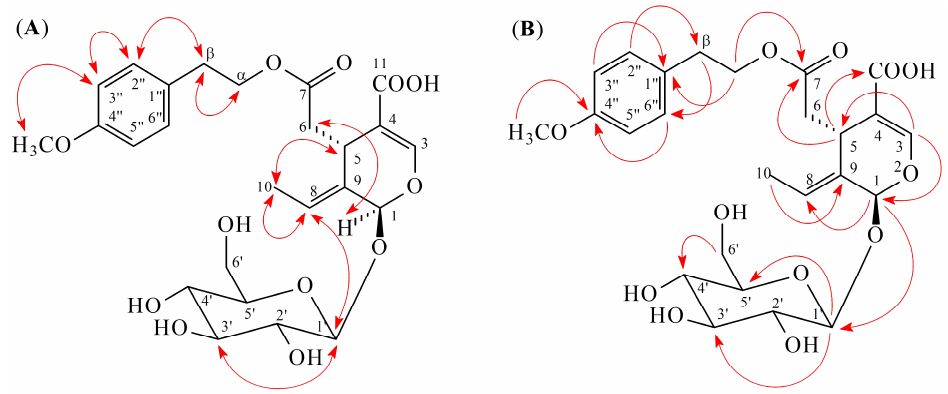
Figure 3. Key NOESY ( A ) and HMBC ( B ) correlations of 2 .